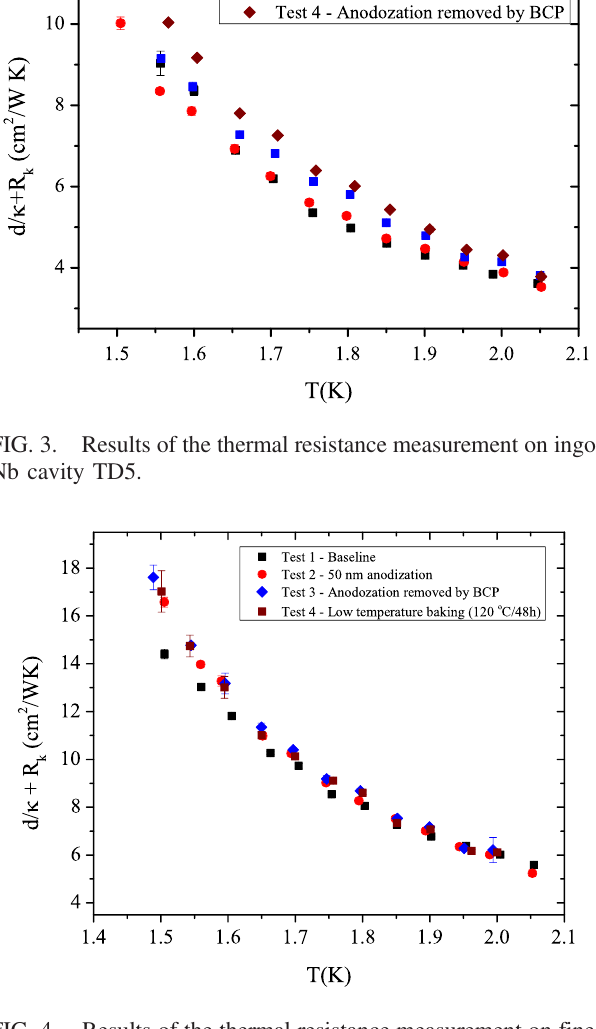
FIG. 4. Results of the thermal resistance measurement on fine- grain cavity